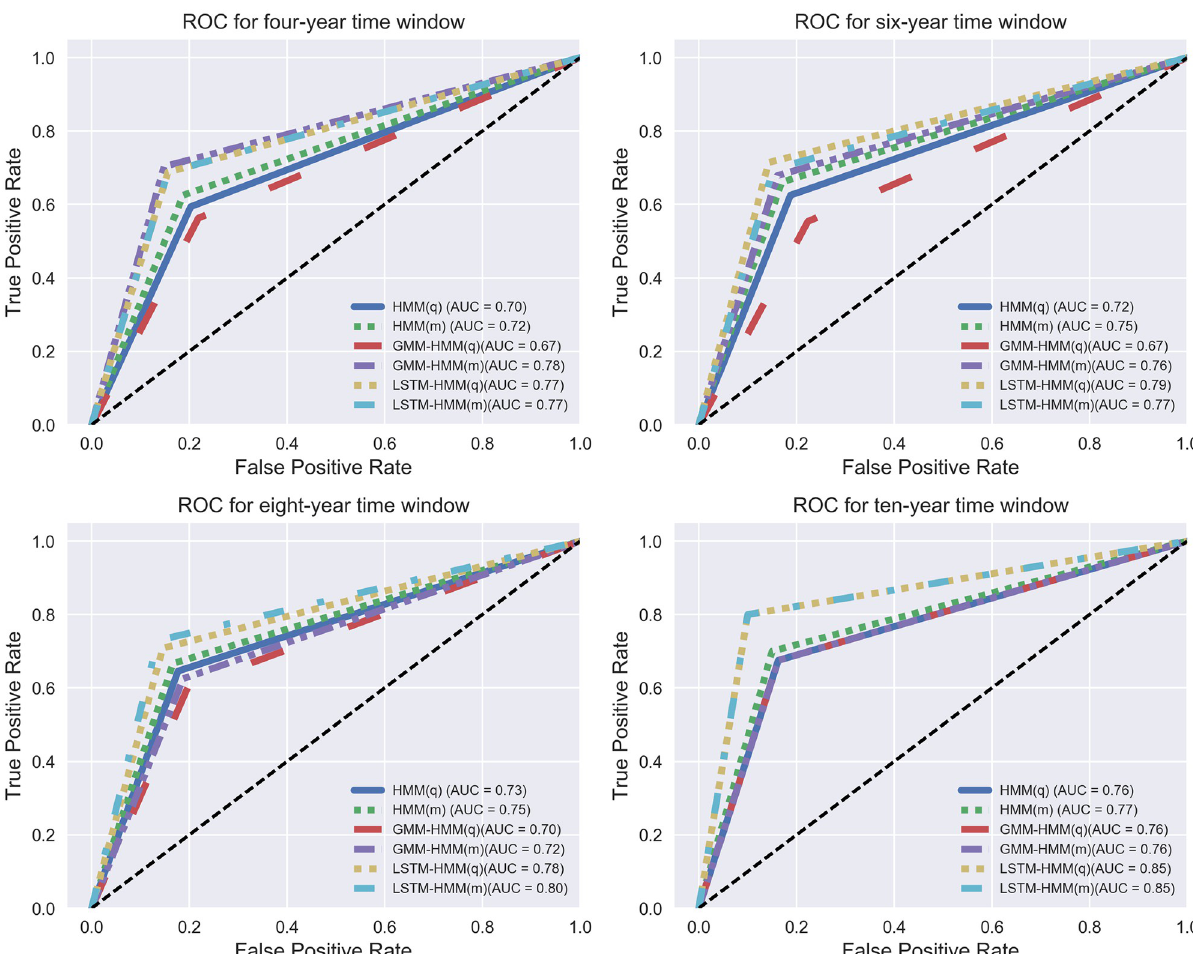
Fig 12. ROC for HMM, GMM-HMM and LSTM-HMM with monthly or quarterly input within 4-year, 6-year, 8-year and 10-year time